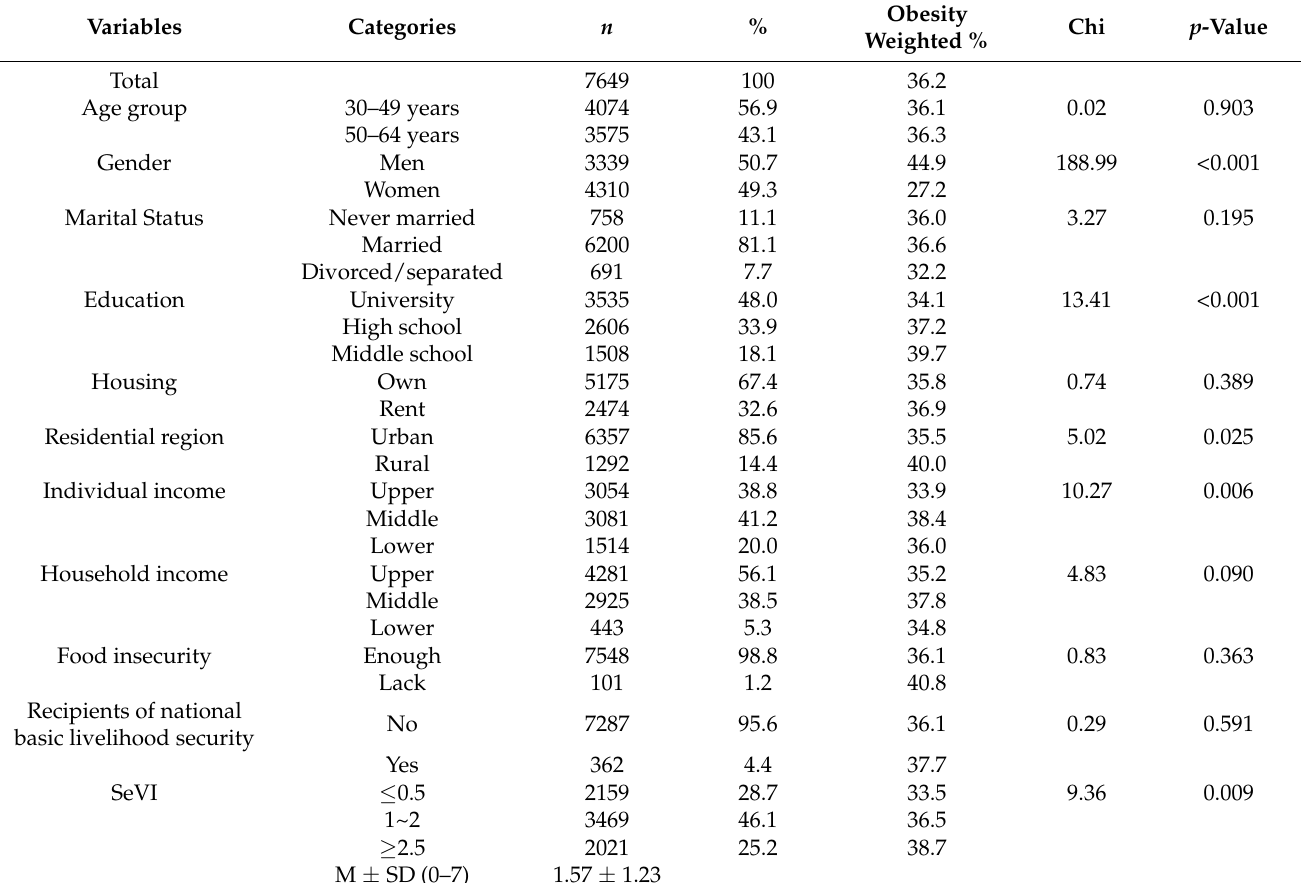
Table 1. Prevalence of obesity by demographic characteristics and socioeconomic status. N =